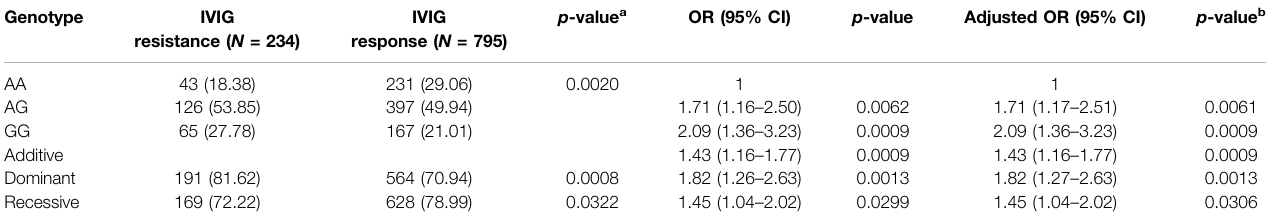
TABLE 2 | Genotype distribution frequency of EIF2AK4 /rs4594236 polymorphism in the IVIG therapy – resistant group and – response group of KD patients. Genotype